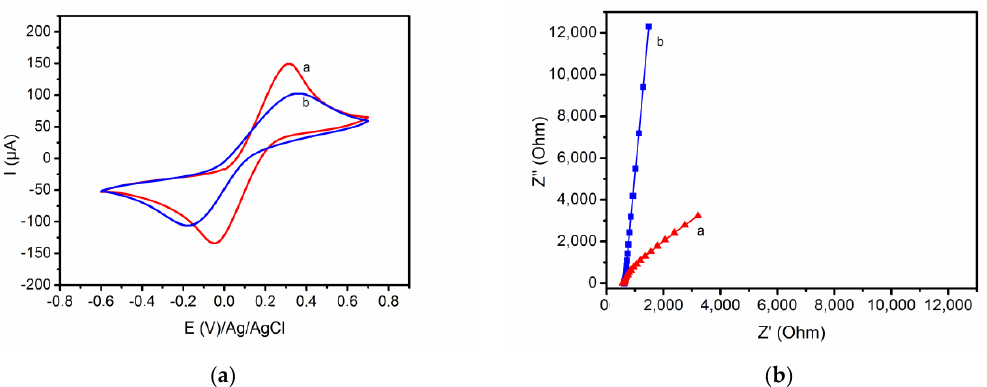
Figure 3. Electrochemical characterization in solution of 5 mM [Fe(CN) 6 ] 3/4– and 0.1 MKCl: ( a ) CVs recorded at scan rate 100 mV/s; ( b ) EIS obtained with frequency range: 100 KHz to 0.1 Hz with DC of 10 mV with (curve a) SPCE/LA–MoS 2 and (curve b) SPCE/LA–MoS 2 /APT.